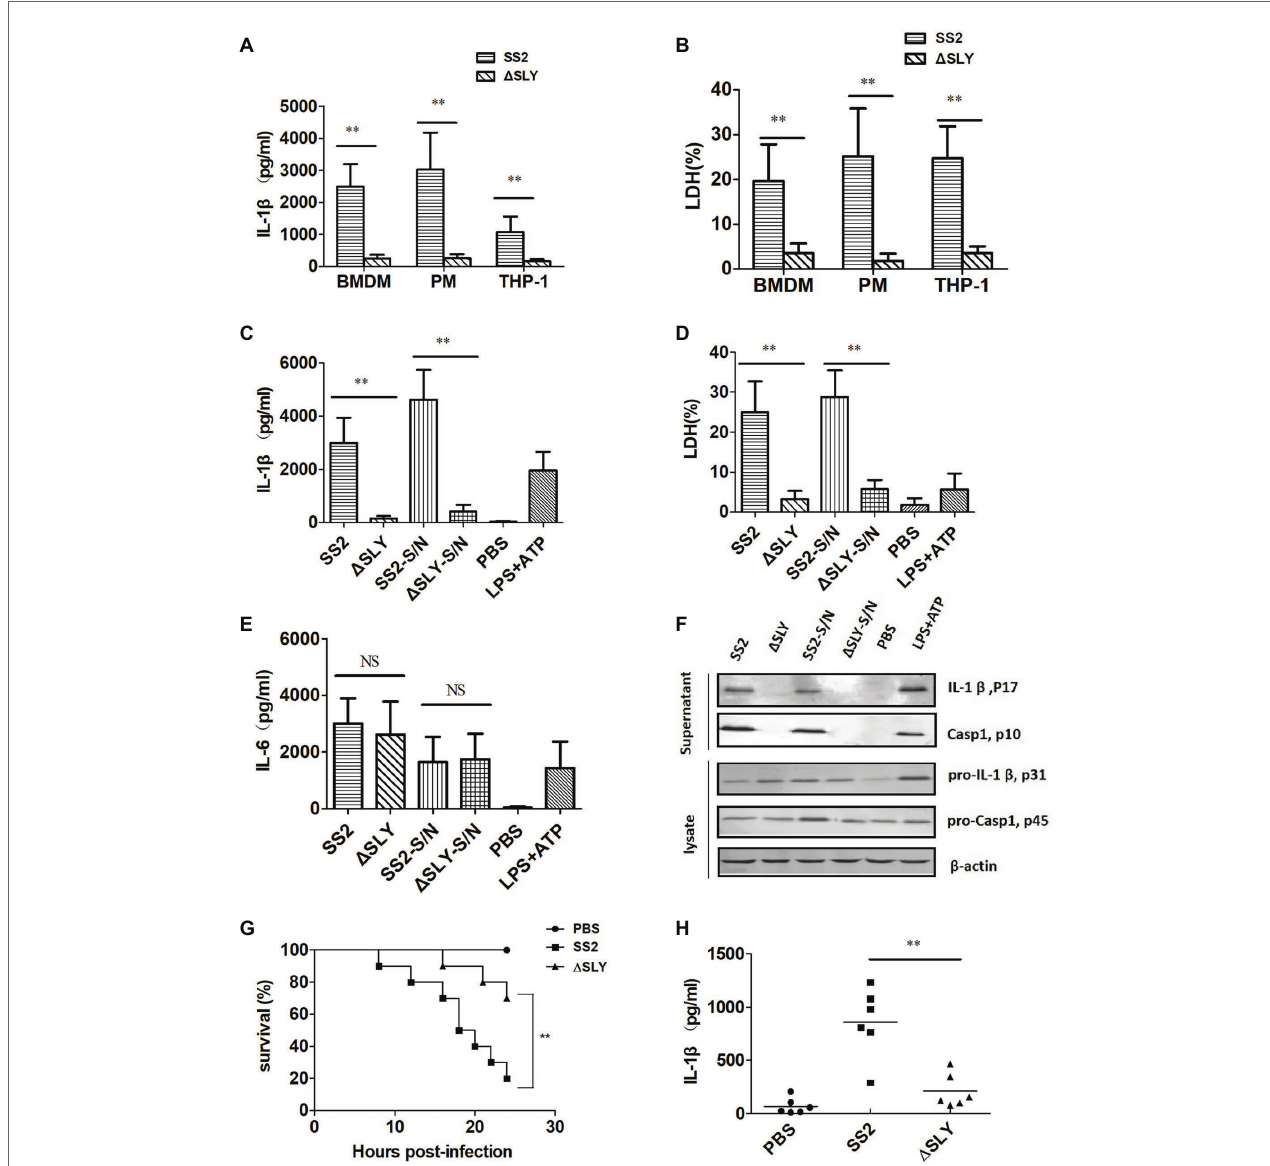
FIGURE 2 | SS2-induced secretion of IL-1 β is dependent on suilysin (SLY) in vitro and in vivo . (A,B) Three types of cells, including human monocytic THP-1 cells, mouse peritoneal macrophages (PMs), and BMDMs, were infected with SS2 or its SLY-deficient mutant ( ∆ SLY); multiplicity of infection (MOI, 1) for 16 h. The supernatants were harvested for the measurement of IL-1 β (A) and LDH (B) . (C–E) BMDMs (1 × 10 6 cells/ml) were infected with SS2 or ∆ SLY (MOI, 1) for 16 h and also treated in parallel with the concentrated supernatant proteins SS2-S/N (200 ng/ml) or ∆ SLY-S/N (200 ng/ml) for 16 h after LPS priming for 3 h. Phosphate buffer saline (PBS) and LPS plus adenosine triphosphate (ATP) were used as the negative control and positive control, respectively. The supernatants were collected for IL-1 β (C) and IL-6 (E) by ELISA and LDH assay (D) . (F) Immunoblotting was performed, and the culture supernatants were measured for IL-1 β p17 and Caspase1 p10, and the cell lysates were analyzed for proIL-1 β p31 and pro-Caspase1 p45. (G) 8-week-old C57BL/6J WT mice were injected intraperitoneally (IP) with a higher dose of SS2 or ∆ SLY (2 × 10 9 CFU/mouse in 200 μ l PBS) and their survivals were observed every 2 h up to 24 h, with 10 mice in each group. The WT mice treated with SS2 and PBS were considered as the positive and negative control group, respectively. (H) 8-week-old WT C57BL/6J mice were injected IP with a lower dose of SS2 or ∆ SLY (2 × 10 8 CFU in 200 μ l PBS). The WT mice treated with SS2 and PBS were considered as the positive and negative control group, respectively. These mice were sacrificed 24 h after injection. Their peritoneal lavage fluids (PLFs) were harvested by rinsing the peritoneal cavity with 500 μ l PBS and measured for IL-1 β by ELISA (six mice in each group). The data shown in panels (A–E) are the means ± standard deviations from three independent experiments. The data shown in panels (F–H) are from one of two independent experiments. * p < 0.05; ** p <